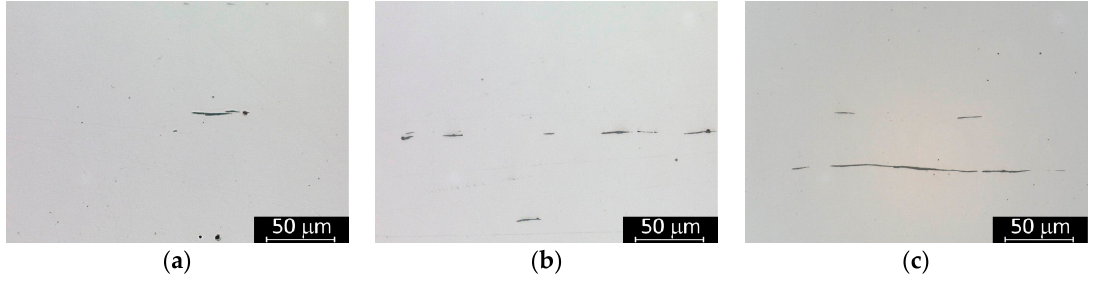
Figure 1. Polished microsections for the alloys ( a ) S76; ( b ) S110; ( c ) S280.